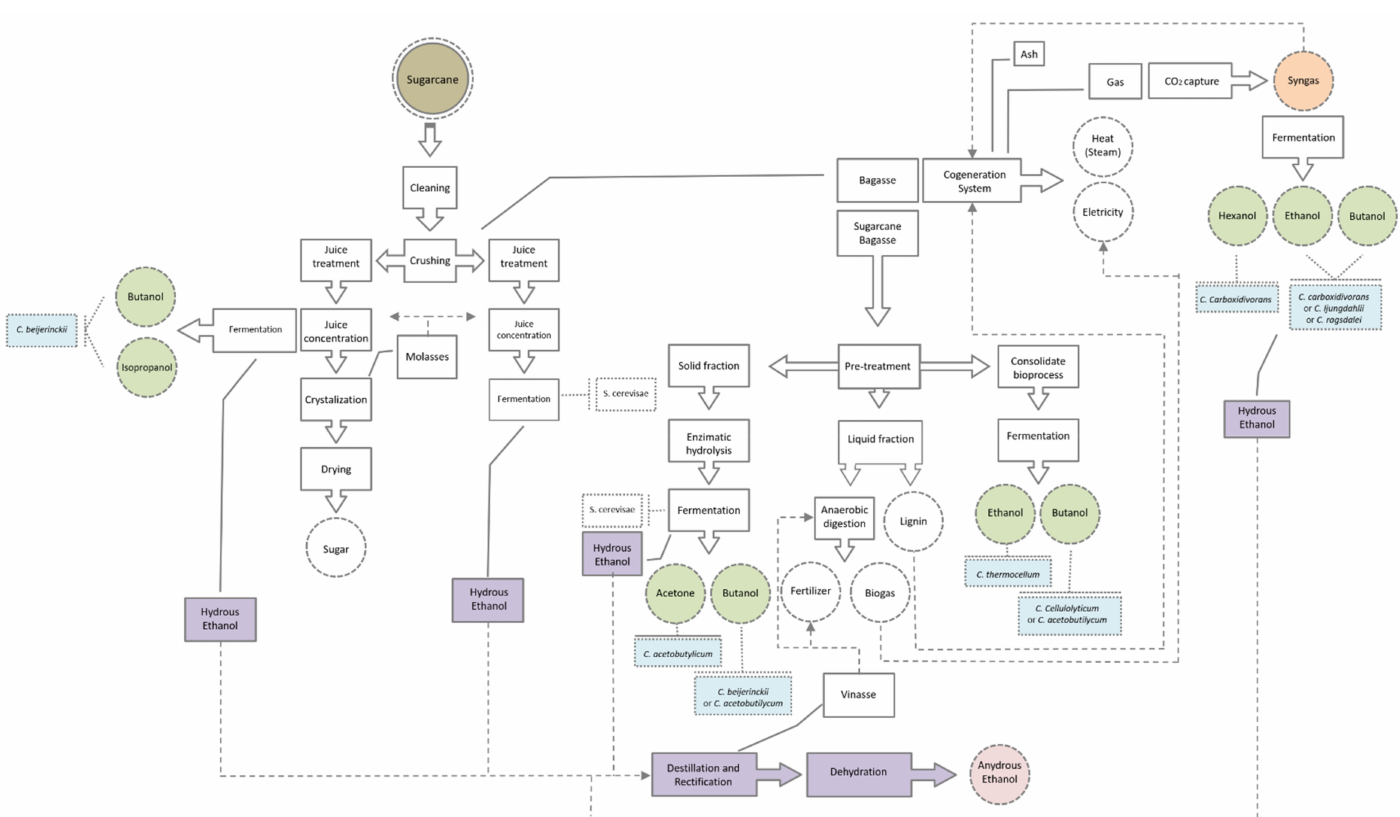
Figure 1. Schematic diagram of a sugarcane biorefinery producing ethanol, sugar, power, butanol, syngas, fertilizer, hexanol, and acetone, based on [238–241] and on information of the present review. Dotted circle—intermediate products and end products; dotted arrows—product destination from one process for use as raw material in another process; blue— Clostridium species; green—direct Clostridium metabolism products; purple—intermediate product after bioprocess using Clostridium species and its process for product refining; red—by-product after bioprocess using Clostridium species; and orange—residue used as raw material for fermentation using Clostridium